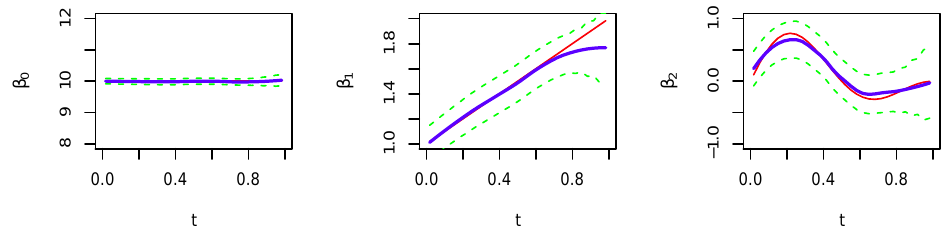
Figure 3. Performance of curve estimation when the sample size is 100 and the random seed is “set.seed(1)” in R. First row: curve estimation performance of the spline smoother; Second row: curve estimation performance of the local polynomial model; Third row: curve estimation performance of the proposed RKHS method. Solid red line: true curve; Solid blue line: estimated curve; Dotted lower and upper green lines: 95% confidence bands.